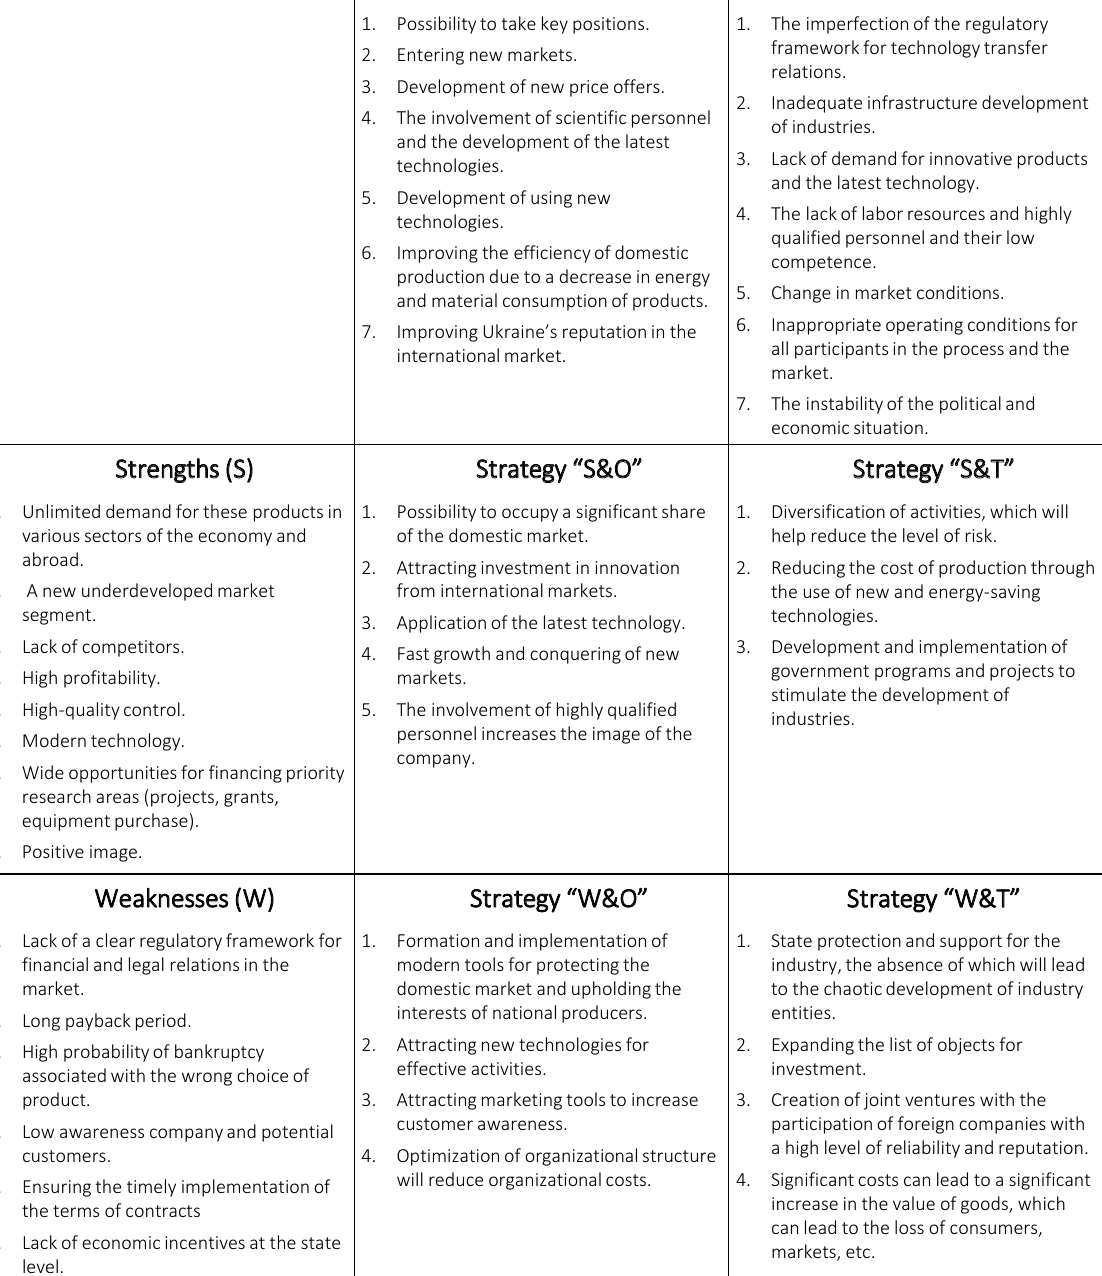
Figure 4. Correlation matrix of the EEN SWOT